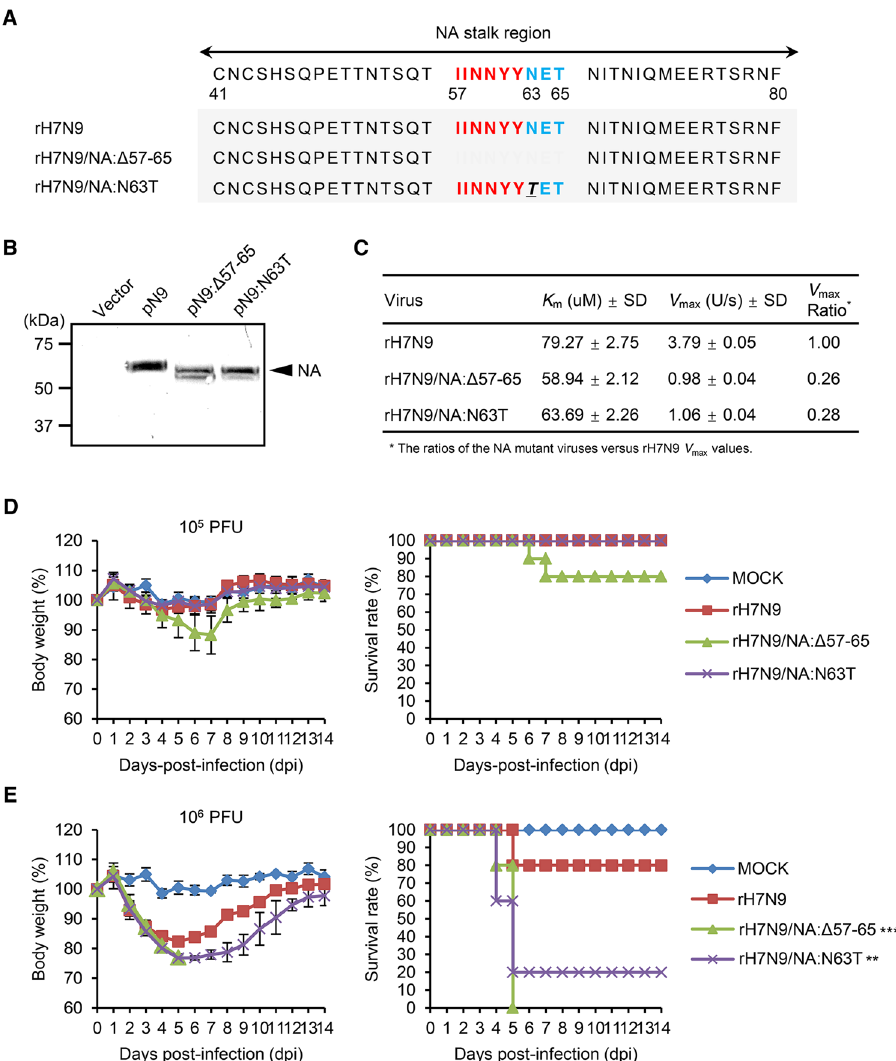
Figure 8. In vitro and in vivo evaluation of the H7N9 vaccine and its NA stalk mutant viruses. ( A ) The H7N9 vaccine (rH7N9) and its NA stalk mutant viruses (rH7N9/NA: Δ 57–65 and rH7N9/NA:N63T) were generated by reverse genetics based on the NA stalk truncation or deglycosylation strategy. ( B ) In the western blotting assay, the NA stalk mutations (truncation and deglycosylation) were confirmed based on the mobility shift of NA proteins. ( C ) The enzyme kinetics data were fit to the Michaelis-Menten equation by nonlinear regression to determine the Michaelis constant ( Km ) and maximum velocity ( Vmax ) of substrate conversion. Results are given as the means ± SD from three independent determinations on triplicate samples where the R 2 was > 0.99. After 10 5 ( D ) and 10 6 ( E ) PFU intranasal infection of each virus, body weight changes and survival rates of the infected mice were represented in average ( ** P < 0.01 and *** P < 0.001 compared with the rH7N9 results).